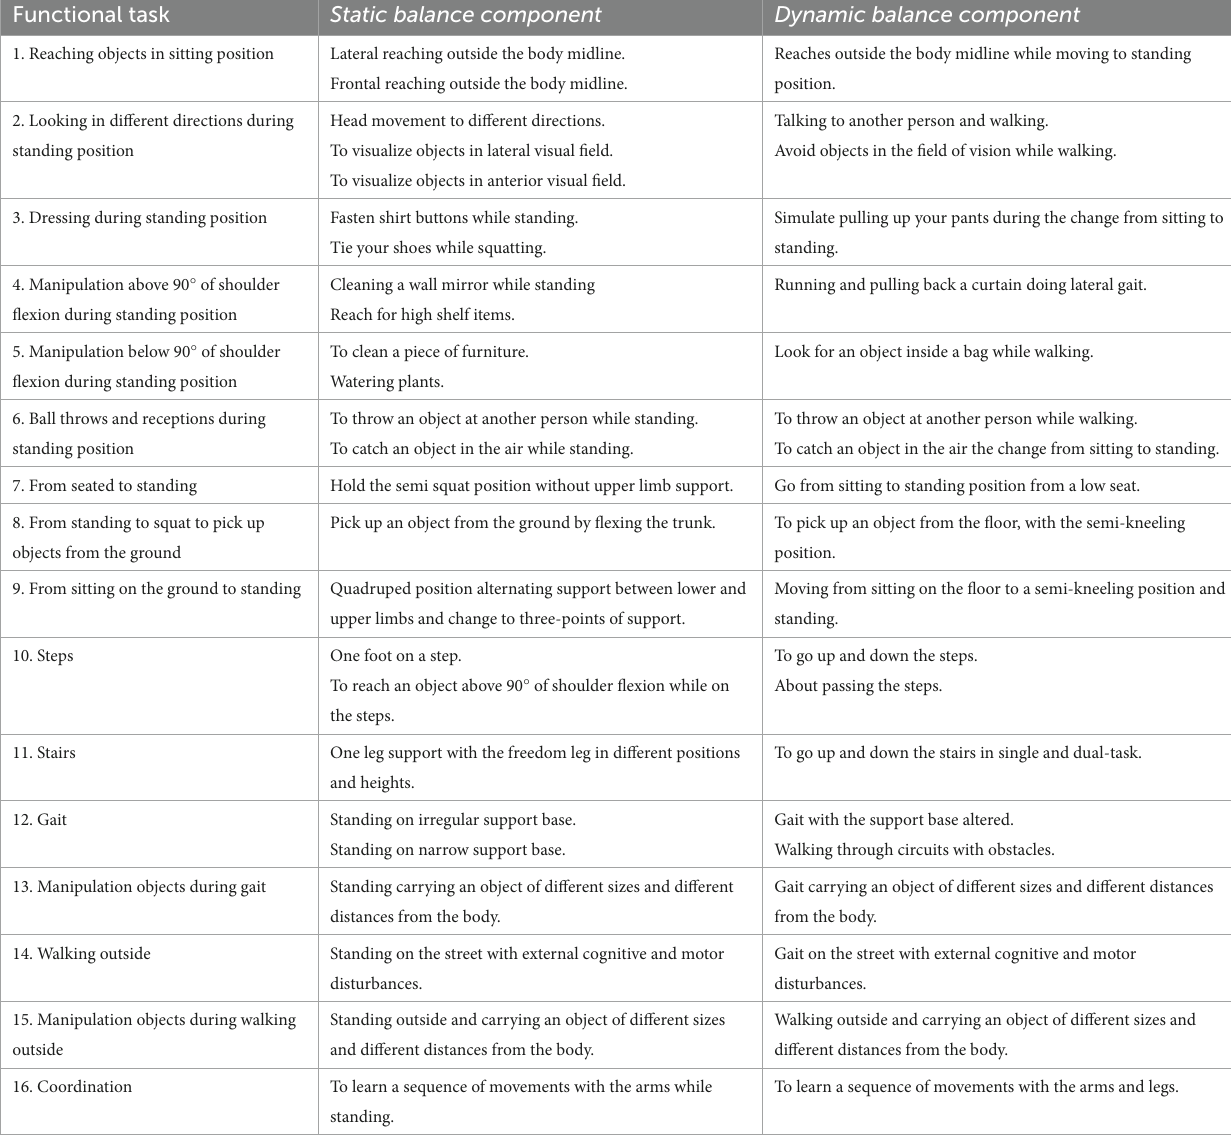
TABLE 1 Functional tasks and balance components from the balanceHOME program. Functional task Static balance component Dynamic balance